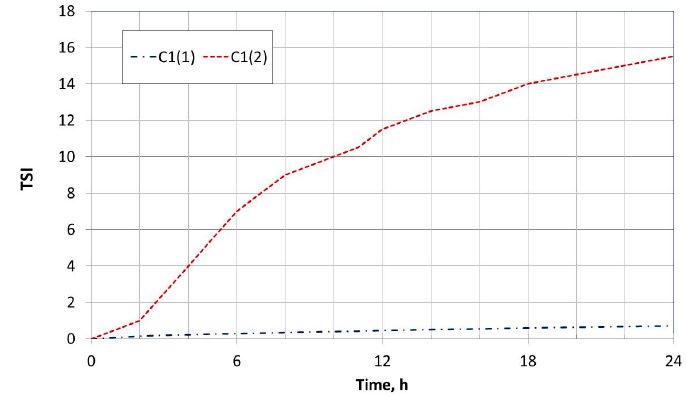
Figure 9. Sample C1. Comparison of the time evolution of the Turbiscan Stability Index ( TSI ) as a function of the modality of preparation.